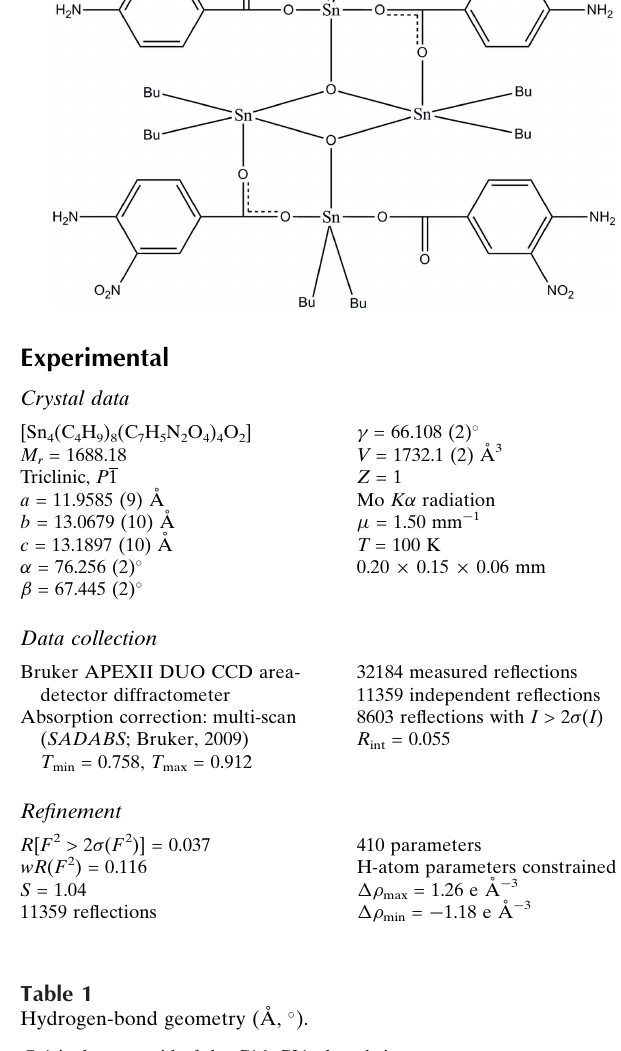
The tetranuclear molecules of the title compound,